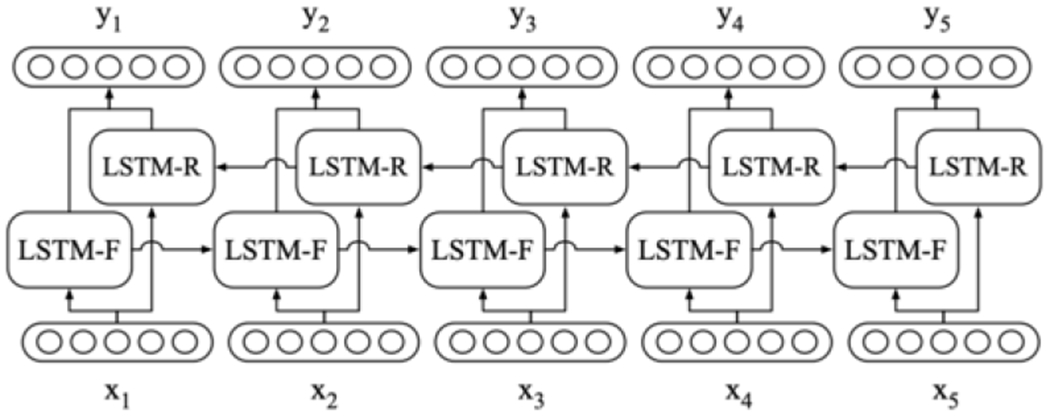
Bi-directional LSTM